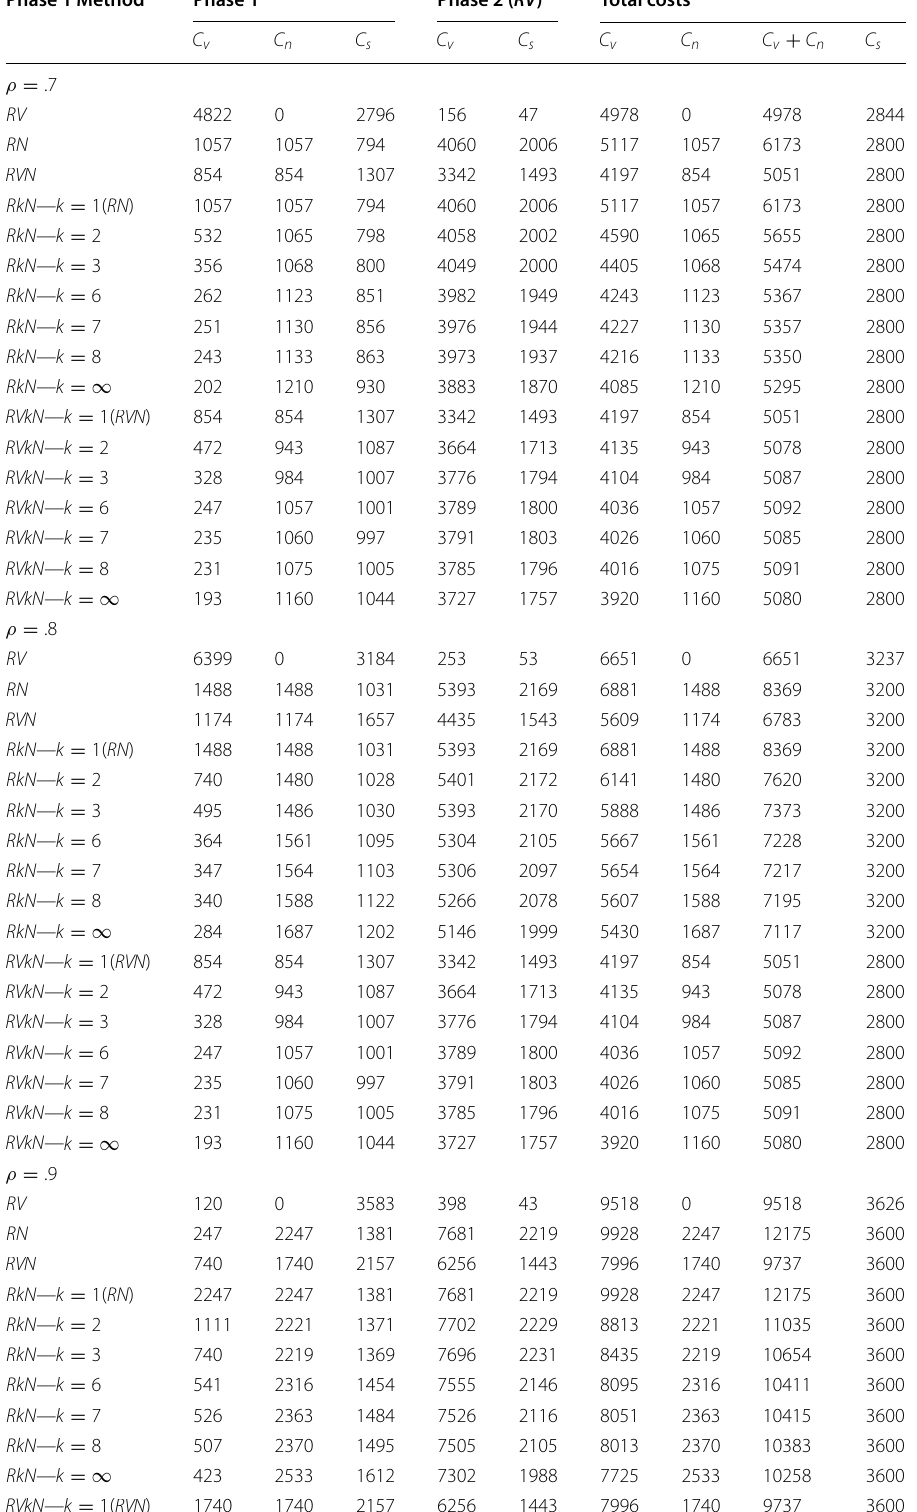
Table 5 Experimentally calculated C v , C n , and C s costs of two‑phase sampling methods in BA graphs Phase 1